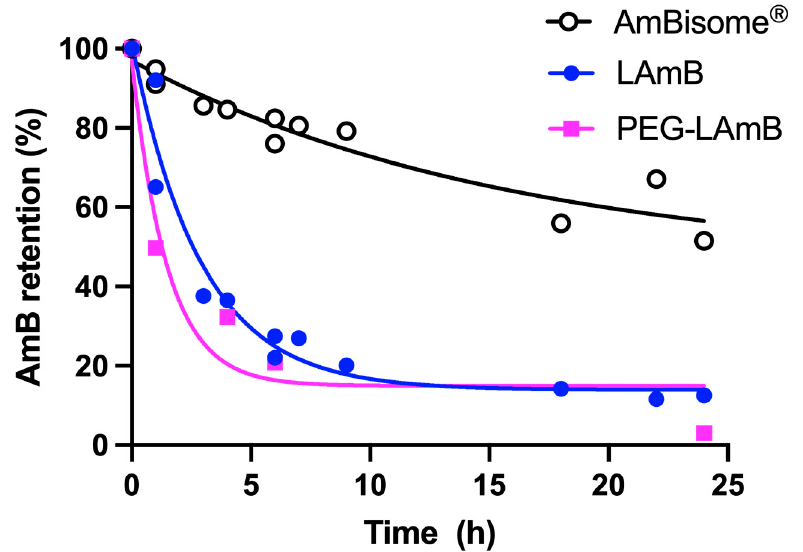
Figure 8. Kinetics of release of AmB at 55 °C from conventional and PEGylated liposomal AmB (LAmB and PEG-LAmB, respectively) prepared according to [77], and AmBisome ® . Dialysis was performed using Spectra-Por ® Float-A-Lyzer ® G2 MWCO 100kDa in the presence of 5% γ -cyclodextrin, according to [76].